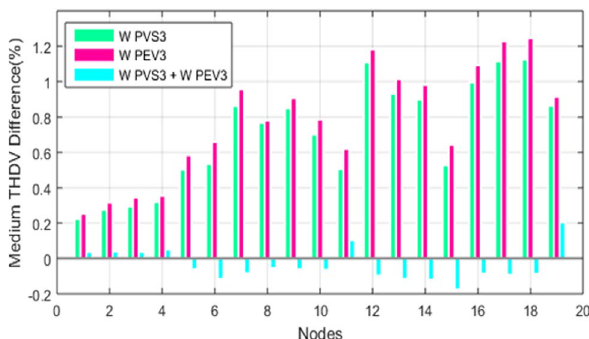
Figure 22. Analysis of system THD differences in maximum level during